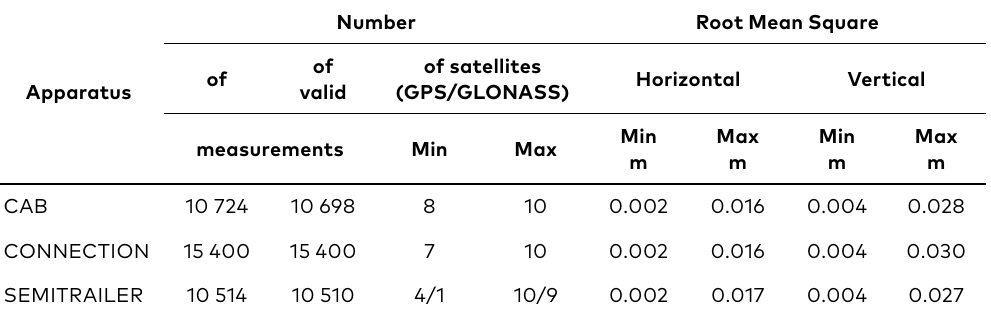
Table 1. Statistics of measured